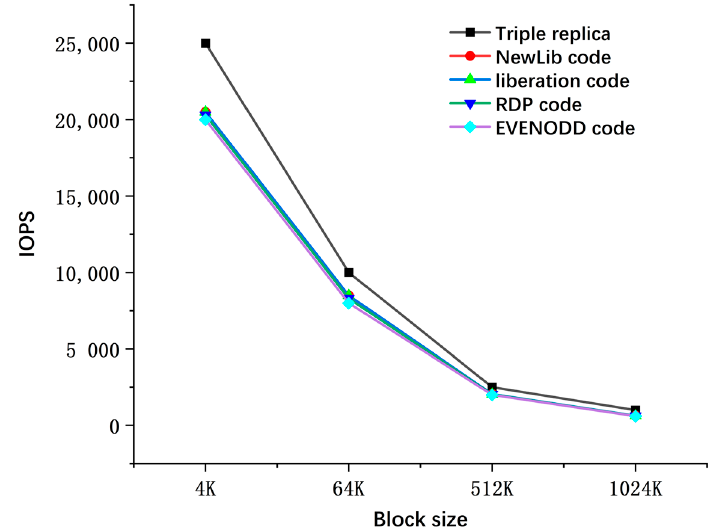
Figure 9. The IOPS in the sequential reading.